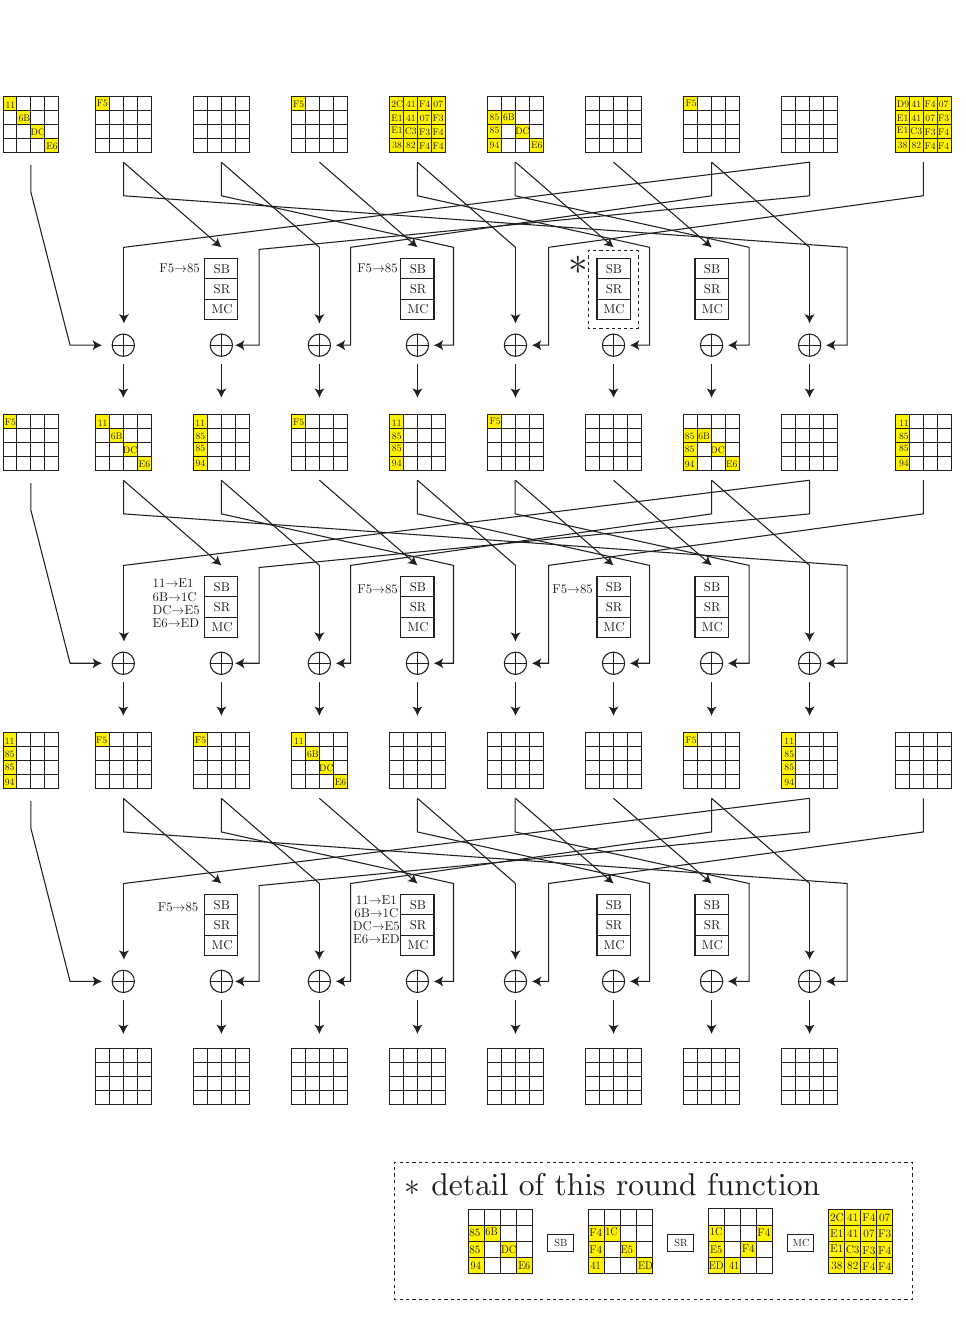
Figure 6: Bottom 3 rounds in the differential trail available for the forgery